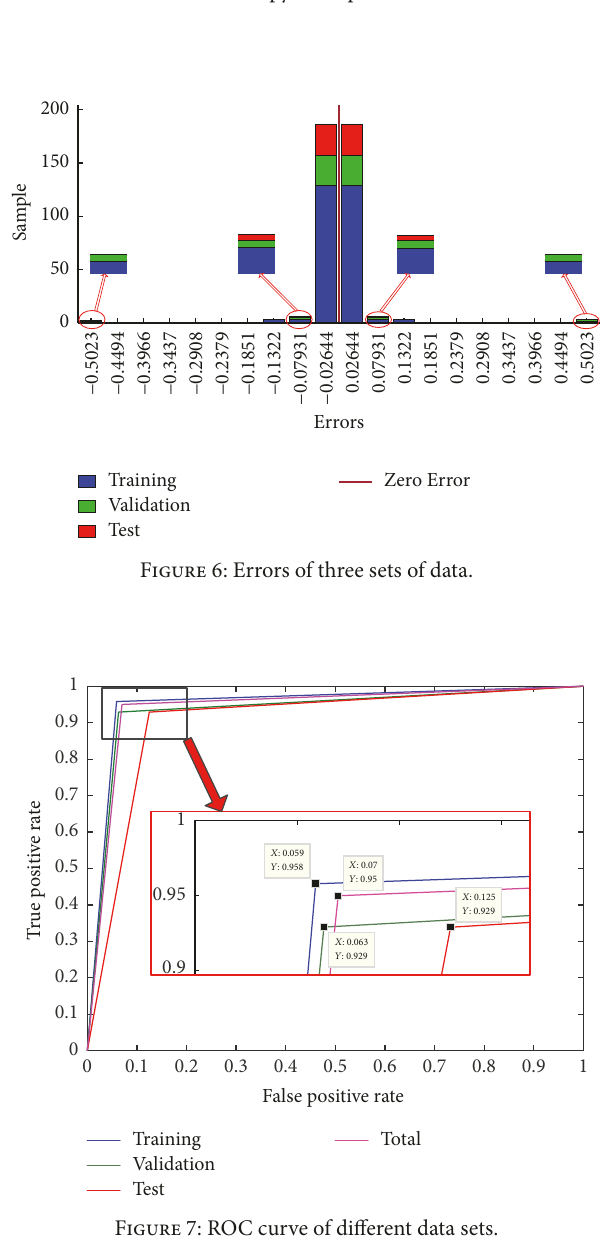
Figure 5: Cross-entropy of loops with different data.